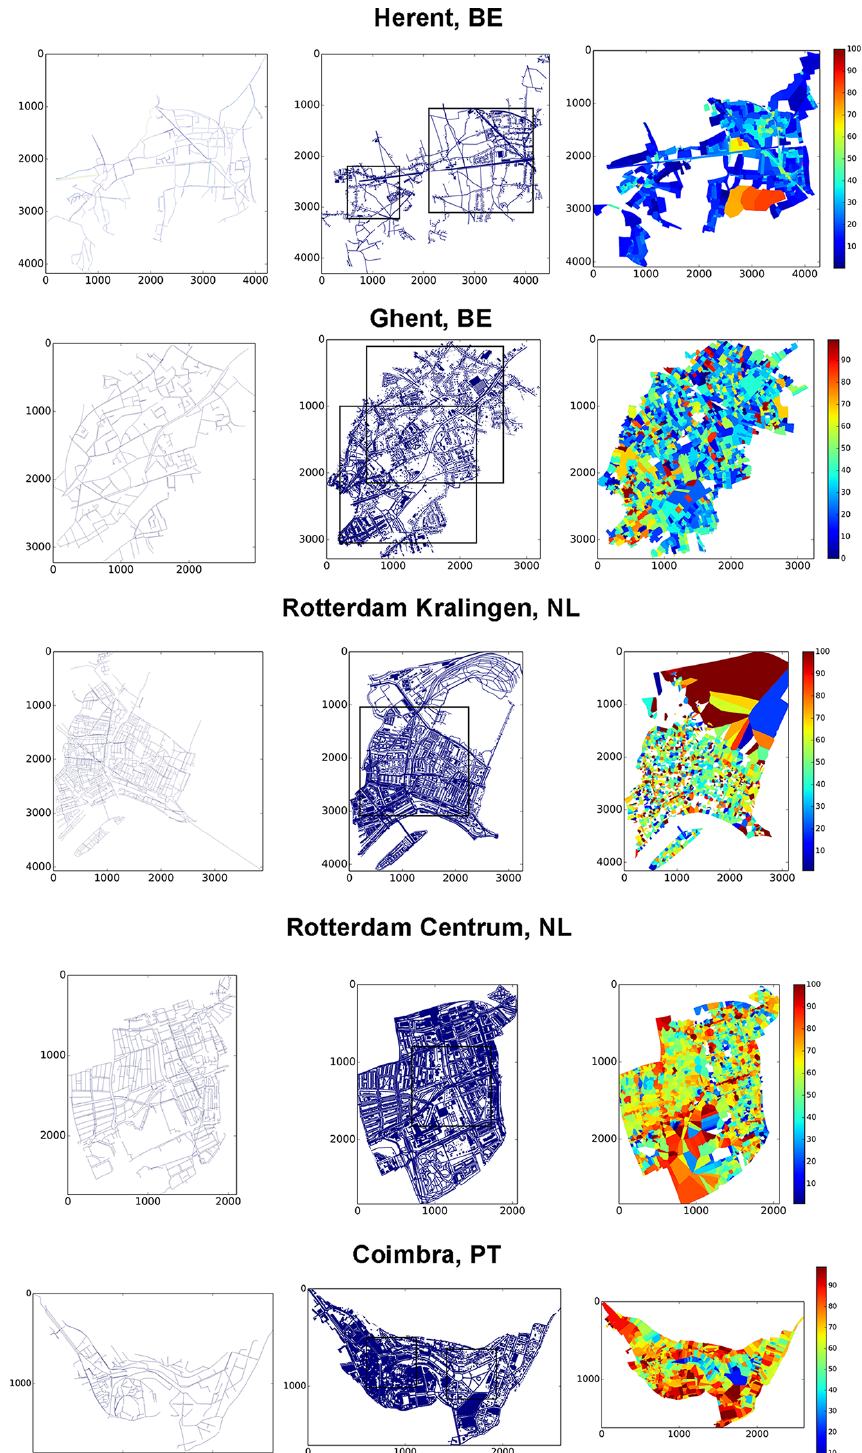
Figure 2. Sewer system (left), distributed imperviousness map with pixels a size of 2m (middle), and maps of the imperviousness (%) as assigned to each sub-catchment in the semi-distributed models (right) of the pilot catchments. The axes correspond to metres (m). The black squares (visible in the middle column) correspond to the studied areas in the fractal